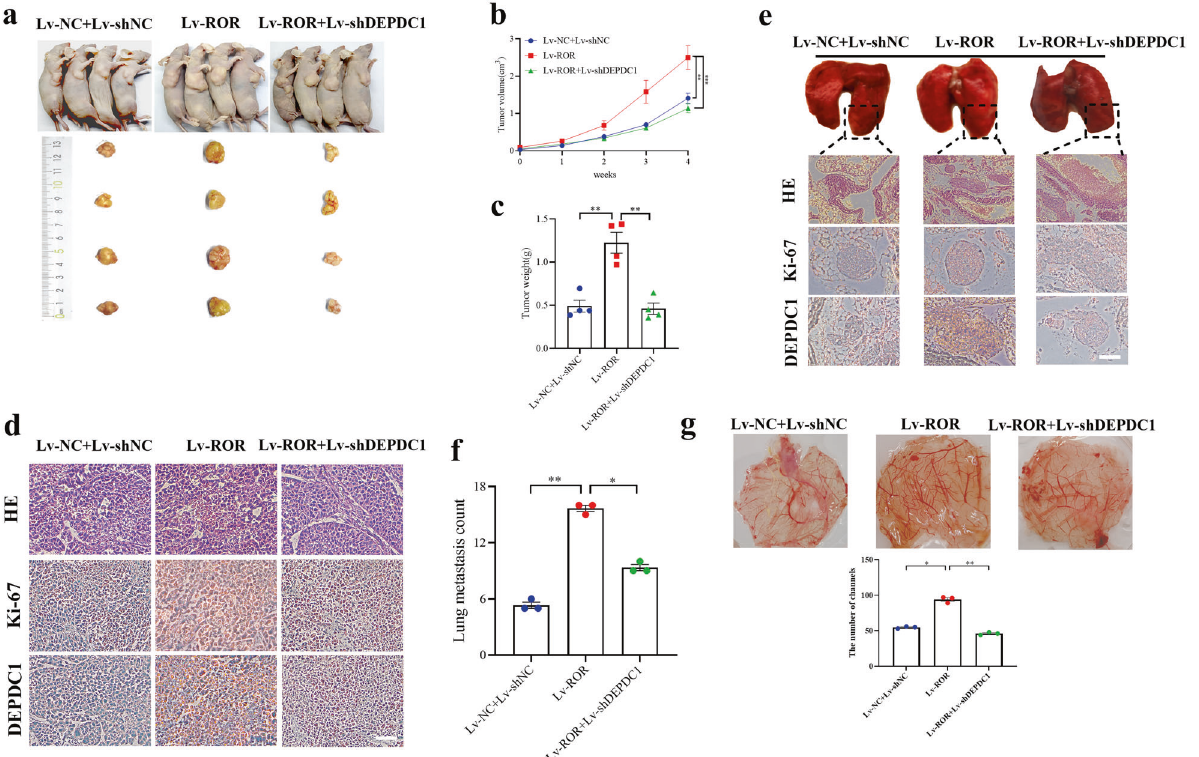
Fig. 7 Carcinogenesis of Linc-ROR requires DEPDC1 in vivo. a − d Representative images, in vivo growth curve, HE, Ki-67 and DEPDC1 immunostaining, and weight at the end points of subcutaneous xenograft tumors formed by HepG2 cells stably transfected with Lv-NC + Lv- shNC, Lv-ROR or Lv-ROR + Lv-shDEPDC1 in nude mice ( n = 4 per group). Scale bar, 100 μ m. e , f In vivo representative images, HE, Ki-67 and DEPDC1 immunostaining, and metastatic counts of lungs of nude mice ( n = 3 per group) treated with tail vein injection of HepG2 cells stably transfected with Lv-NC + Lv-shNC, Lv-ROR or Lv-ROR + Lv-shDEPDC1. Scale bar, 50 μ m. g Linc-ROR promoted angiogenesis by the CAM angiogenesis analysis in HepG2 cells. Data are shown as mean ± SD, n = 3. The data statistical signi fi cance is assessed by Student ’ s t test. * P < 0.05, ** P < 0.01, *** P <